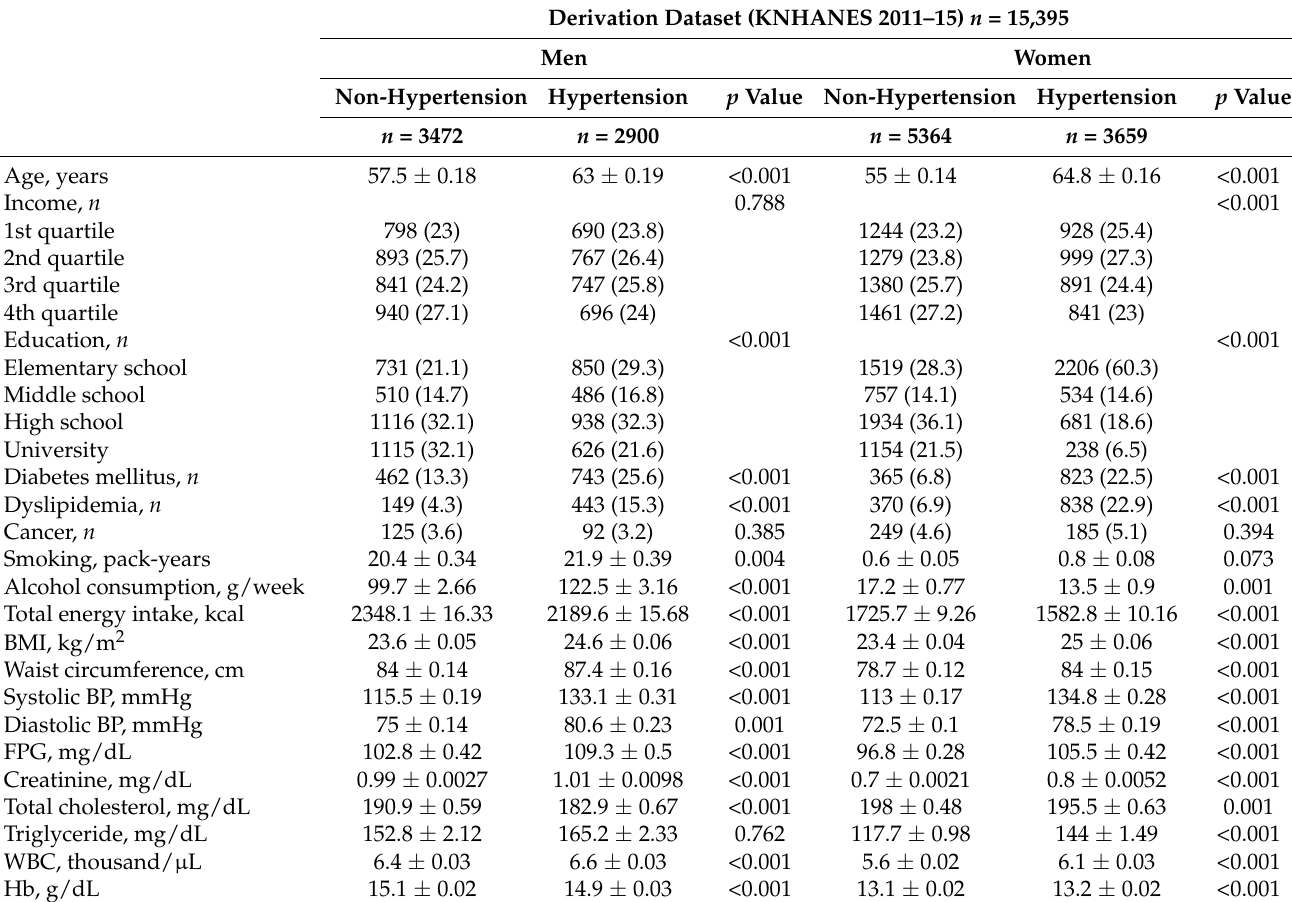
Table 1. General characteristics of derivation dataset (KNHANES